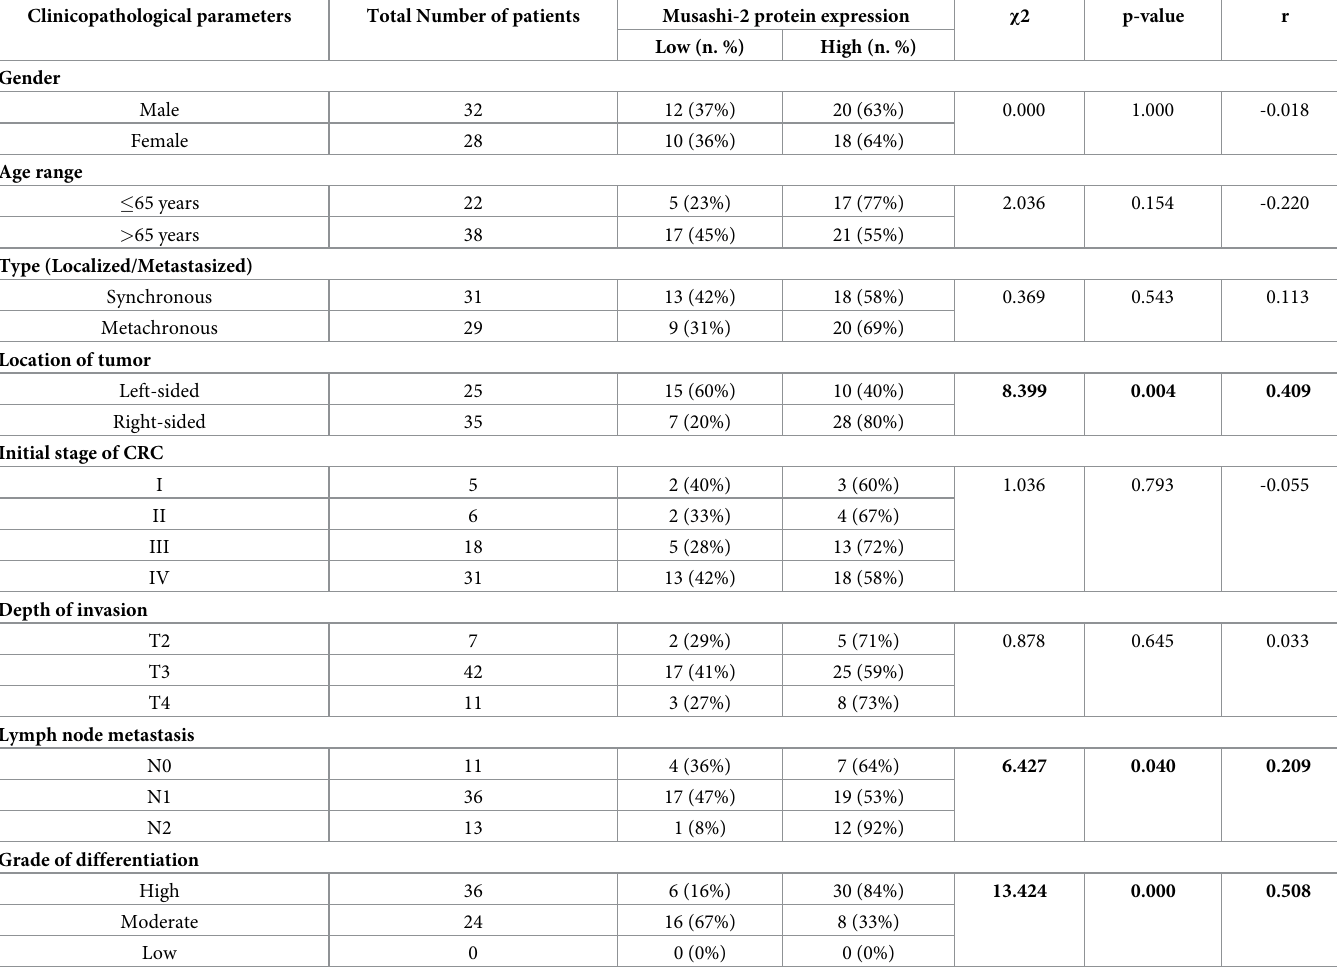
Categorical data were evaluated using the Pearson χ 2 test, adjusted by Yates’s correction for continuity. The correlation coefficients between protein expression and clinical and pathological parameters were estimated using Spearman